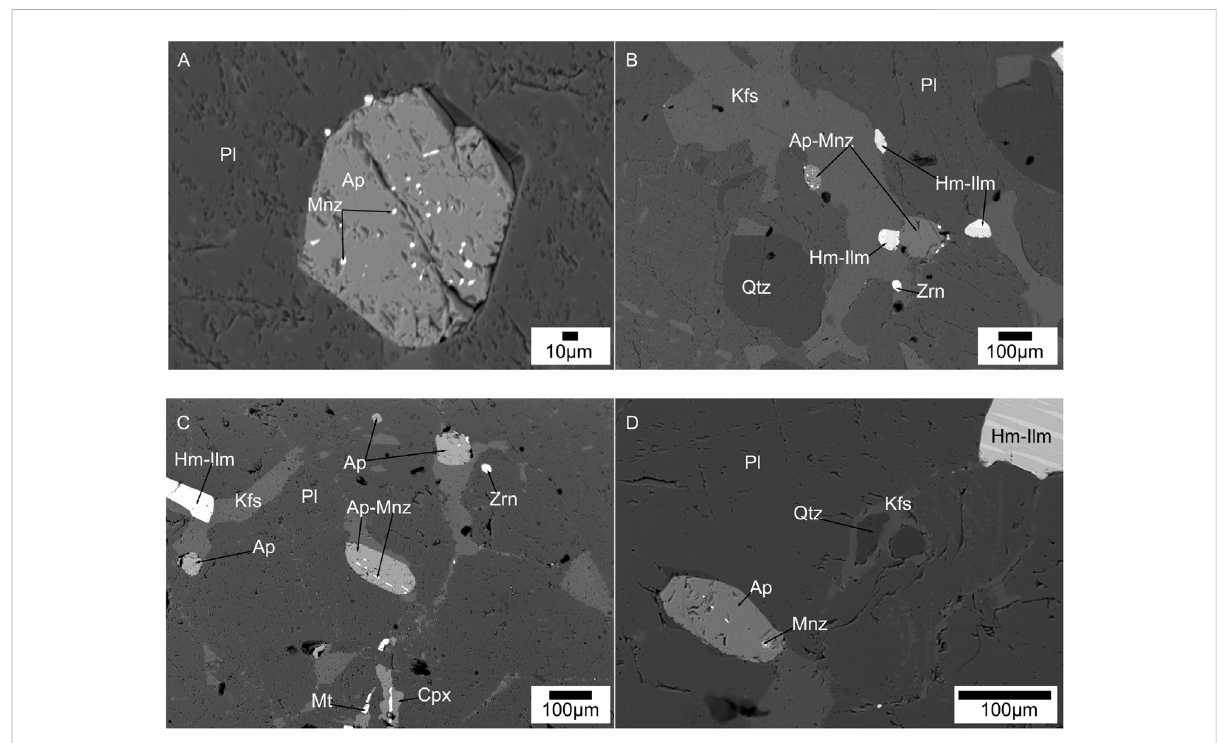
Backscatteredelectronimagesofmineralassemblages inequilibrium andtheirtextures intwo-pyroxenegranulitesamples.Apatite grainswith monazite blebs (A) within plagioclase; (B – D) near K-feldspar veins in matrix of plagioclase and